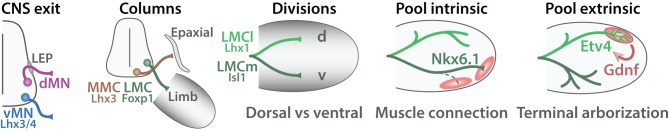
Steps of MN axonal targeting. Schematic summarizing the steps of MN axonal targeting (adapted from Dasen and Jessell, 2009). The first step termed “CNS exit” reflect the choice of developing MNs to exit the CNS via the ventral root (vMNs, blue) or through the lateral exit point (LEP) (dMNs, red). The second choice labeled “Columns” return to the motor column: MMC MNs (brown) target to epaxial musculature whereas LMC MNs (green) project to the limb. The third step named “Divisions” refers to the choice made by the medial and lateral divisions of the LMC. LMCl MNs (light green) invade the dorsal part of the limb (d) whereas LMCm (dark green) MNs target to the ventral region (v). The fourth step termed “Pool intrinsic” refers to the selection of a specific muscle target (red) and is controlled by intrinsic cues. The last step named “Pool extrinsic” illustrates the induction of specific protein expression upon a signal from the muscle target, which coordinates the terminal arborization of MN axons. Proteins involved in each step are indicated.